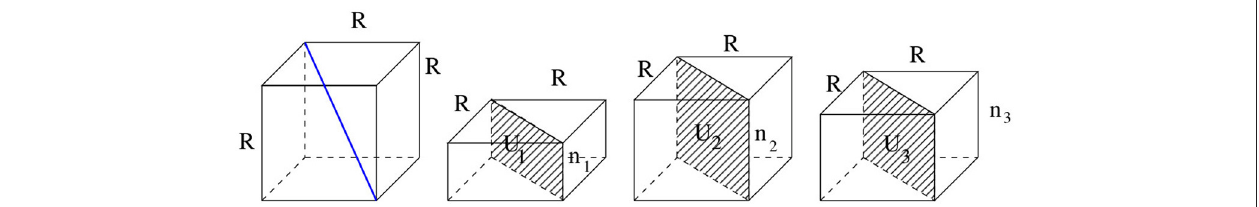
FIGURE 1 | Illustration to the contracted product representation Equation (2) of the rank- R canonical tensor. The first factor corresponds to the diagonal coefficient tensor ξ .